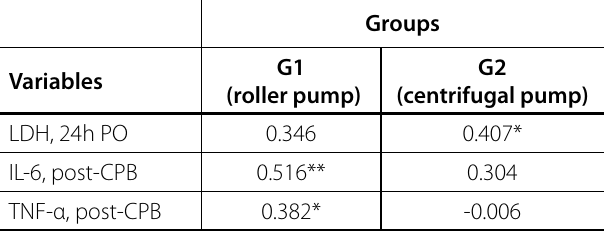
Table 4. Spearman coefficients of linear association between duration of CPB and markers of hemolysis and inflammation, stratified by group.